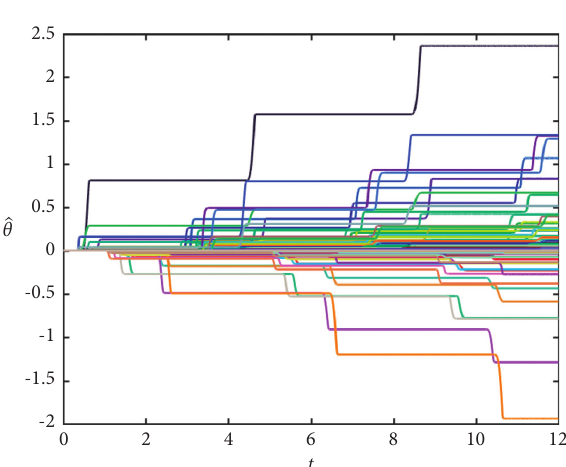
Figure 5: Control input u for Example 1.